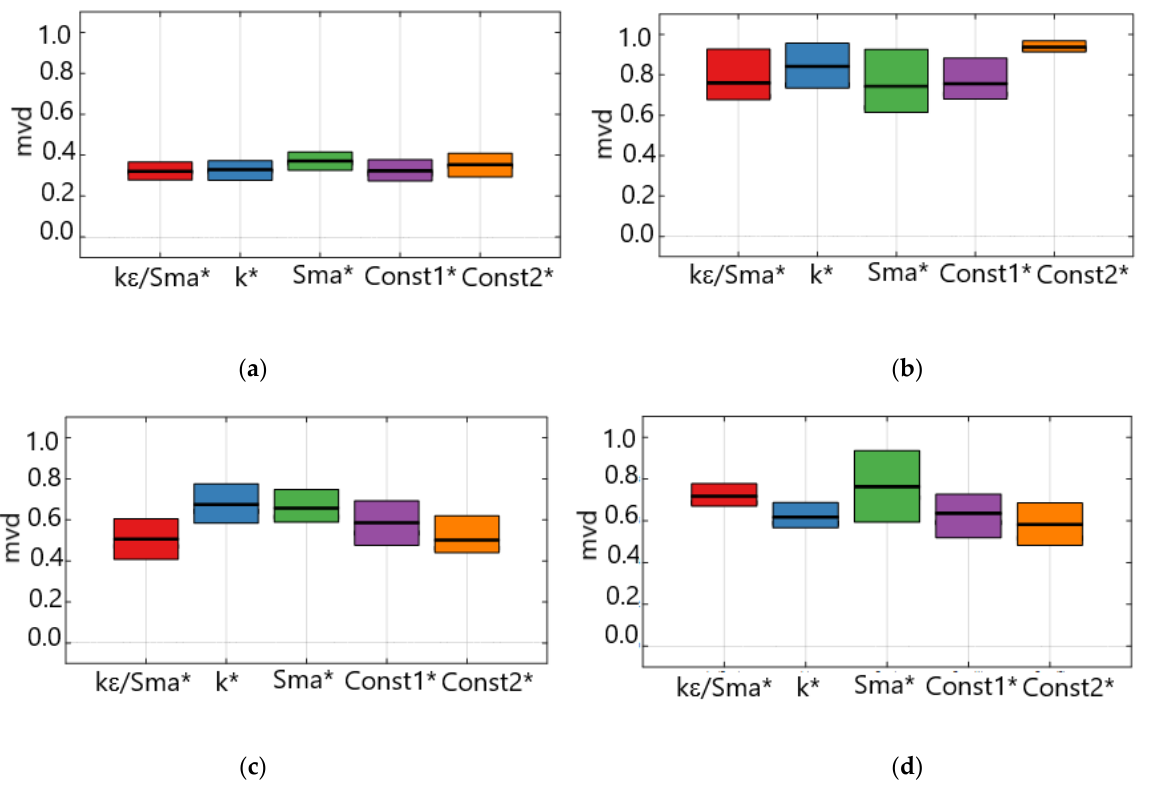
Figure 11. Mvd index for the salinity, for St1 ( a ), St2 ( b ), St5 ( c ), and St6 ( d ). Figure 12a – d shows the mvd index for the temperature for the same stations as previously. St1 and St2 display moderate to high index values within the range (0.4, 0.6) for all schemes, whereas St5 and St6 show significantly higher values (0.4, 1.0), with st6 showing index values close to 1. In other words, St5 and St6 are the most sensitive stations to the temperature compared to the baseline or subjected to significant temperature bility. The distinction between the near-mouth deeper areas and the far-end shallow areas can account for this.